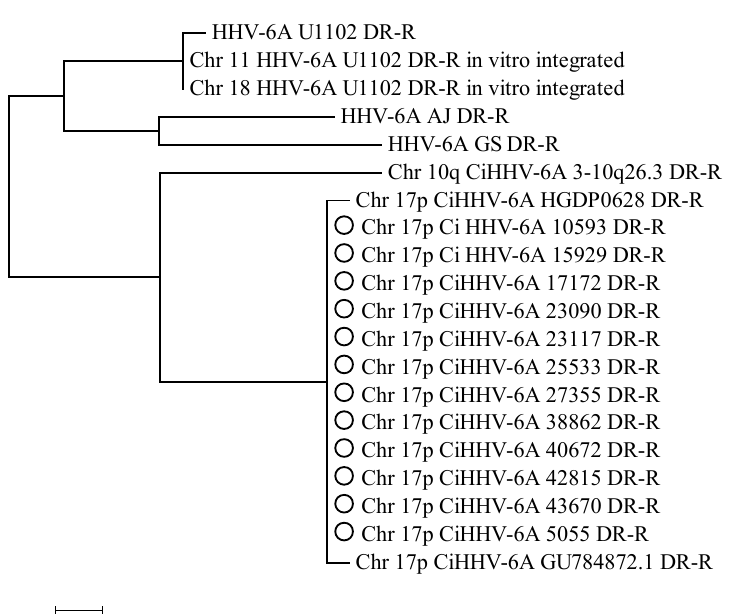
Figure 3. Phylogenetic analyses show the DRR adjacent sequence compared between CiHHV-6A integrated at 17p compared to other chromosomes, with 100% bootstrap (1000×) support main nodes.